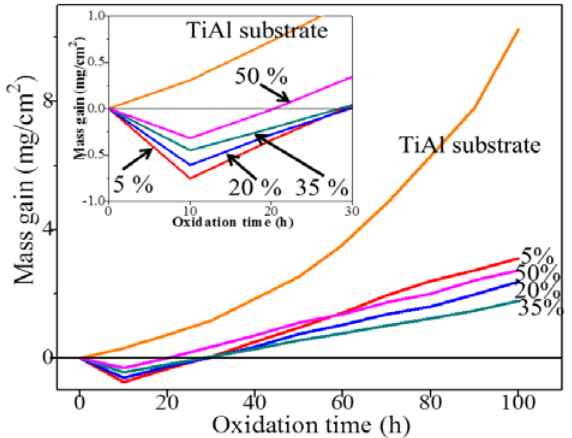
Figure 9. The intermittent isothermal oxidation kinetics curves of TiAl alloy substrate and CPED coatings at 800 °C.